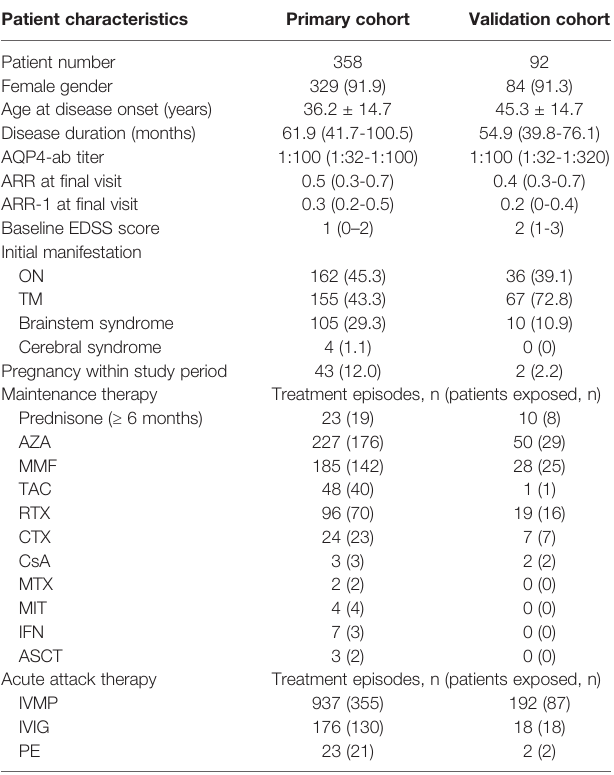
TABLE 1 | Baseline demographic and clinical characteristics of AQP4-ab positive NMOSD patients. Patient